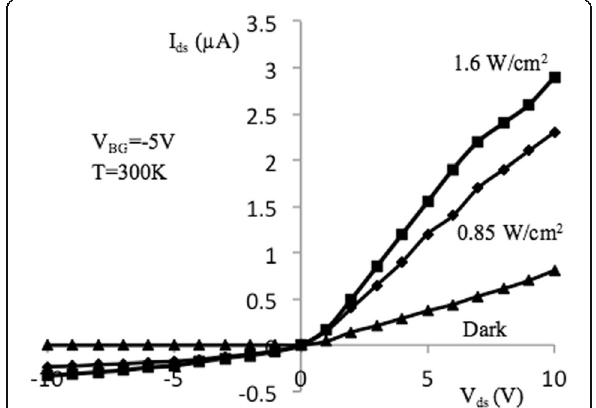
Fig. 6 I – V characteristics of NW FET, measured in pH solutions ( V FG = − 5 V). Output current – voltage characteristics of NW FET with length, l = 10 μ m, measured in the dark and pH concentrations 6.3, 7, 8.2 at T = 300 K, V BG = − 5 V, and V FG = − 5